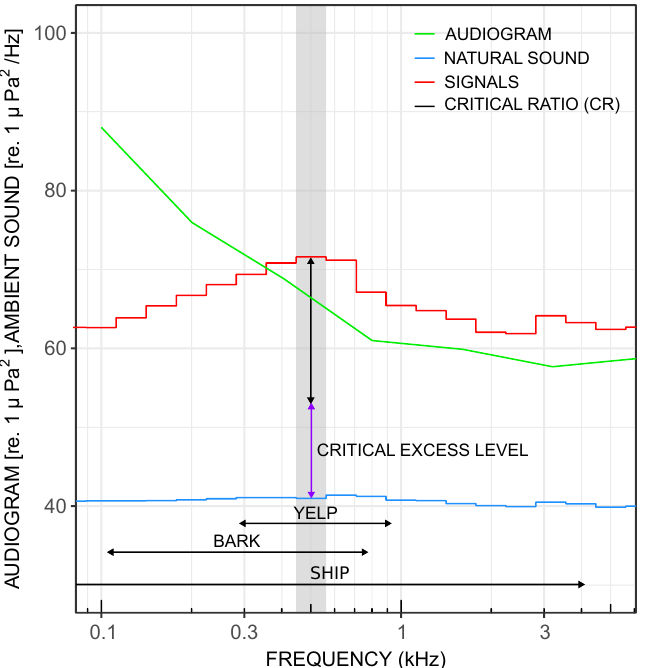
Figure 13. A 12 dB elevation of the ambient sound, called the critical excess level (purple line), can initiate ringed seal call masking. Averaged TOB mean-square sound pressure spectral density level of natural ambient sound and seal calls are shown in blue and red lines. The audiogram of the ringed seals is shown with a green line. The grey area shows the 500 Hz